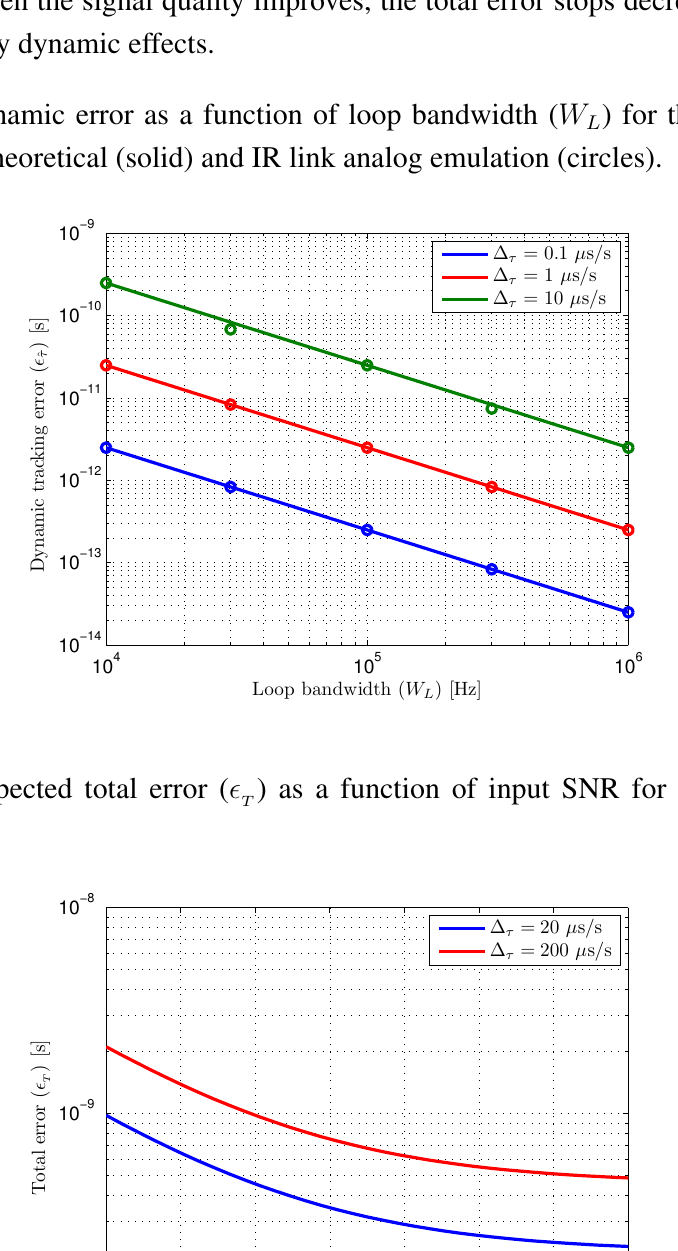
) for three delay rates of L